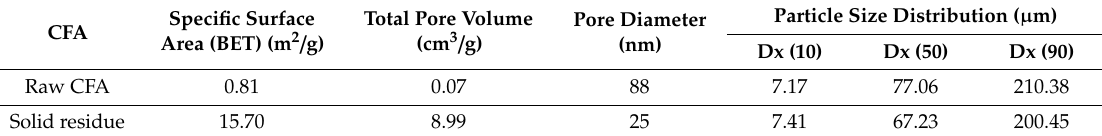
Table 7. The textural properties and particle size of the raw CFA and the solid residue after desilication. Specific Surface CFA Area (BET) (m 2 / g)